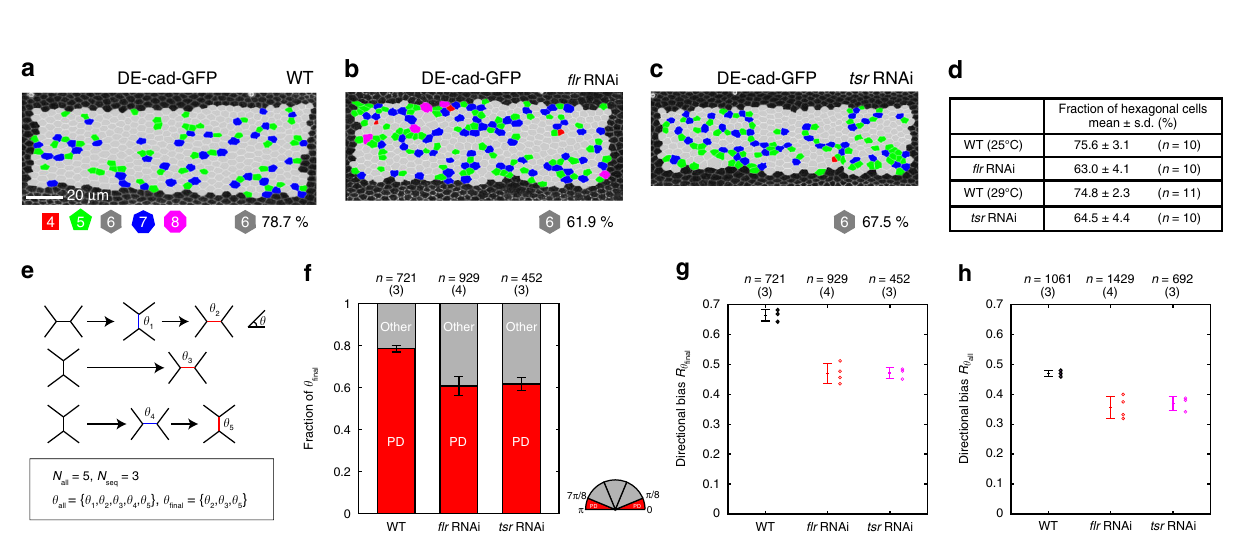
Fig. 2 AIP1 and co fi lin are required for the ef fi cient hexagonal cell packing and directional cell rearrangement. a – c Images of DE-cad-GFP with the indicated genotypes ( a WT at 32 h APF; b flr RNAi at 32 h APF; and c tsr RNAi at 28 h APF at 29 °C, which corresponds to ~32 h APF at 25 °C). Cells are colored according to the number of junctions (red, square; green, pentagon; gray, hexagon; blue, heptagon; and magenta, octagon). d Table of the fraction of hexagonal cells for each indicated genotype. Welch ’ s t -test: WT (25 °C) vs. fl r RNAi, P < 0.001, WT (29 °C) vs. tsr RNAi, P < 0.001. e Schematic of cell rearrangement analysis. We tracked individual junctions that appeared in a movie and measured their angle relative to the PD axes ( θ i ) of newly generated junctions based on cell rearrangement. θ fi nal and θ all are the sets of angles from the fi nal round and all rounds of cell rearrangement, respectively, from which the magnitude of directional bias R θ fi nal and R θ all were calculated (METHODS). N seq and N all indicate the numbers of remodeled junctions and cell rearrangements, respectively. f – h Quanti fi cation of cell rearrangement for each genotype based on time-lapse data captured at 24 – 27 h APF at 25 °C (WT, fl r RNAi) and time-lapse data acquired at 20.5 – 23 h 20 m APF at 29 °C ( tsr RNAi). f PD (red) and other (gray) fractions of θ fi illustrated with a semicircle. g , h R θ fi nal ( g ) and R θ all ( h ) of each genotype. g Dunnett ’ s test: WT vs. fl r RNAi, P < 0.001, WT vs. tsr RNAi, P < 0.001. h Dunnett ’ s test: WT vs. fl r RNAi, P < 0.01, WT vs. tsr RNAi, P < 0.01. The number of pupae ( d ), and the numbers of events and pupae examined ( f – h ) are indicated. Data are presented as the mean ± s.d. ( d , f – h ). Scale bar: 20 µ m ( a localized at AP junctions following the l-o-f of two core PCP components, prickle ( pk ) 44 and fl amingo / starry night ( fmi / stan ) 45,46 (Fig. 3i – m), indicating that PCP is not required for correct localization of AIP1.